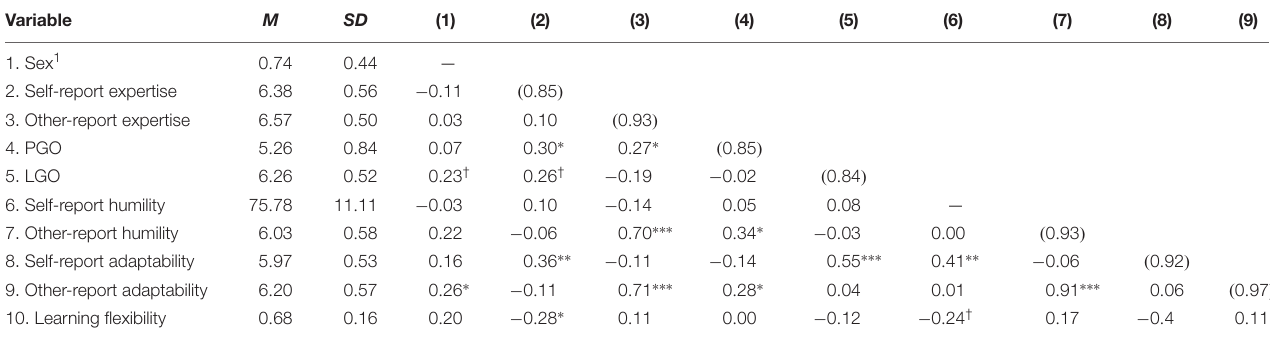
TABLE 1 | Descriptive statistics and zero-order correlations among study variables.